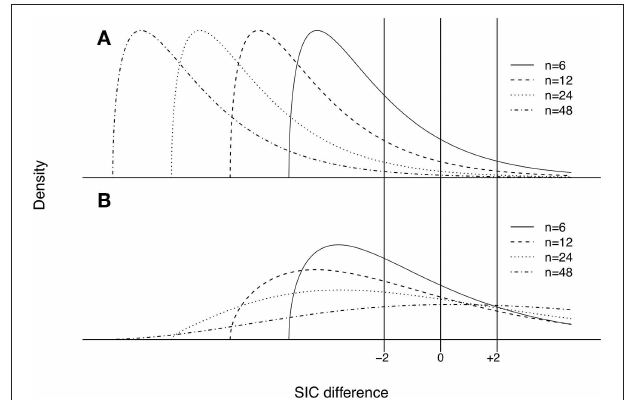
FIGURE 9 | (A) Chisquare distribution of the difference of SIC values, when data arise from model 1 nested within model 2. The chisquare distribution is shifted left as sample size increases. (B) Non-central chisquare distribution of the difference of SIC values, when data arise from model 2 (but not model 1), plotted for increasing sample